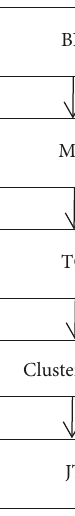
Figure 5: The process of constructing a